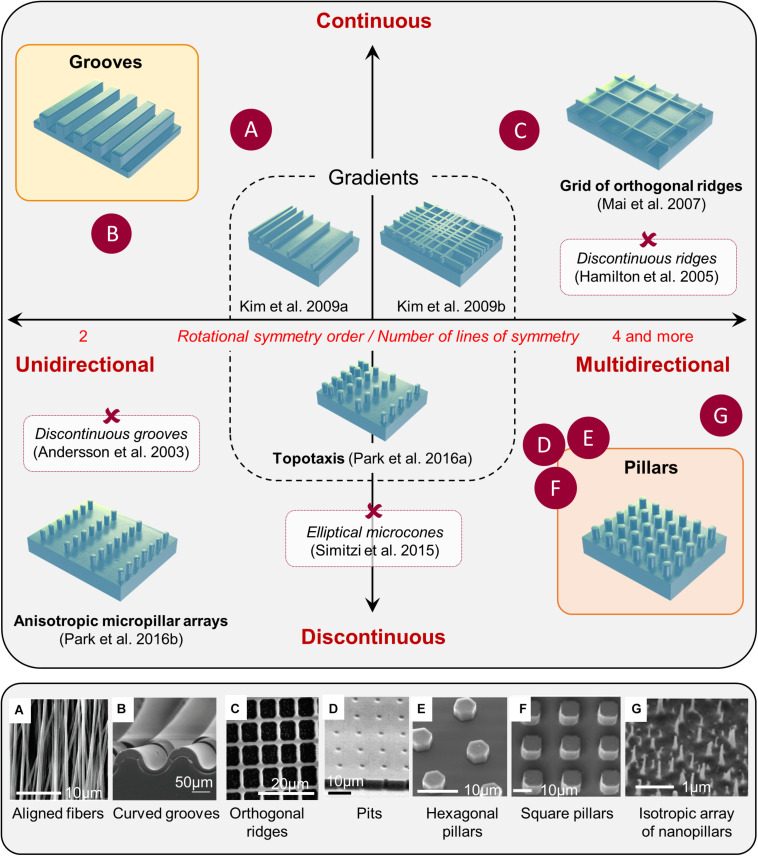
Classification of microstructured substrates. Most microstructured substrates found in the literature can be classified according to its rotational symmetry order (unidirectional toward multidirectional), and the continuous or discontinuous nature of the topographical cues. Examples of various substrates mentioned in the review are positioned in the classification (red crosses), and some examples are illustrated in the bottom panel (letters): reproduced with permission from (A) Adapted with permission from Patel et al. (2007). Copyright 2007 Americal Chemical Society. (B)
Tomba et al. (2019); (C)
Kim et al. (2009b); (D)
Tan et al. (2000); (E)
Micholt et al. (2013); (F)
Leclech et al. (2019). (G) Adapted with permission from Patel et al. (2007). Copyright 2007 Americal Chemical Society.